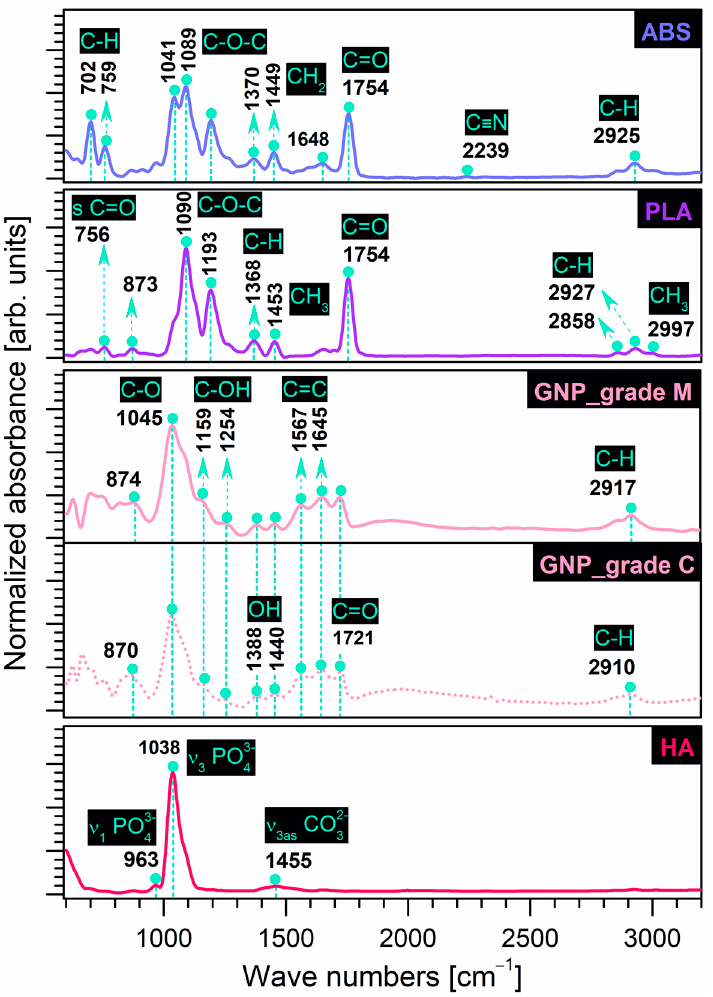
Figure 1. Comparative FT-IR spectra of prime (ABS, PLA) and reinforcement (GNP, HA) precursor materials.